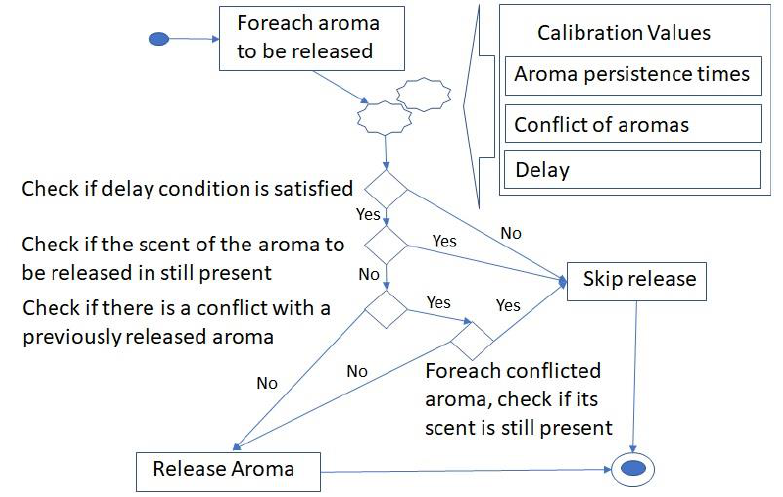
Figure 8. The smart release algorithm.